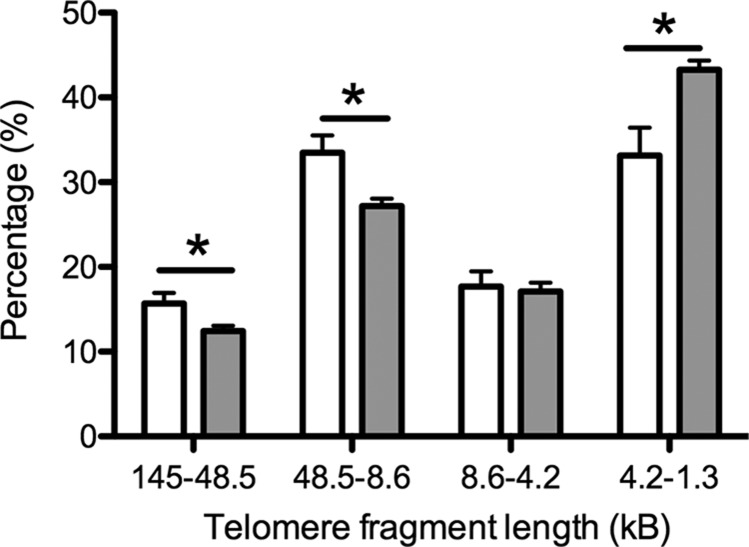
Ovarian telomere length in adult female rats exposed to gestational hypoxia compared to normoxia. Data shown as means ± sem. Open bars: normoxia (21% oxygen) during gestation; gray bars: hypoxia (13% oxygen) during gestation. *P < 0.05.